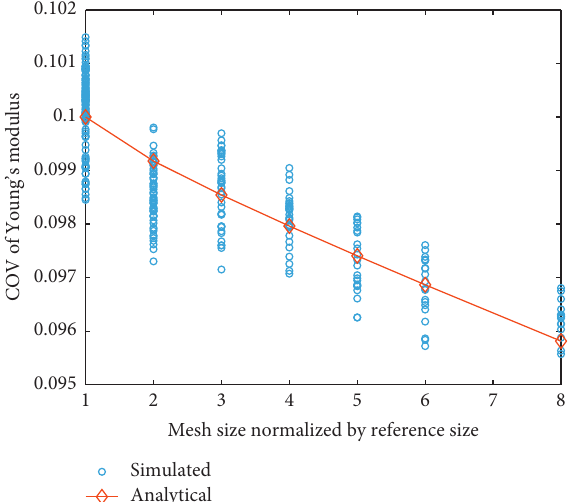
Figure 8: COV of Young’s modulus for the random fields at different scales. Each point of the simulated data represents the COV of a mesh element based on the 10,000 MCSs.